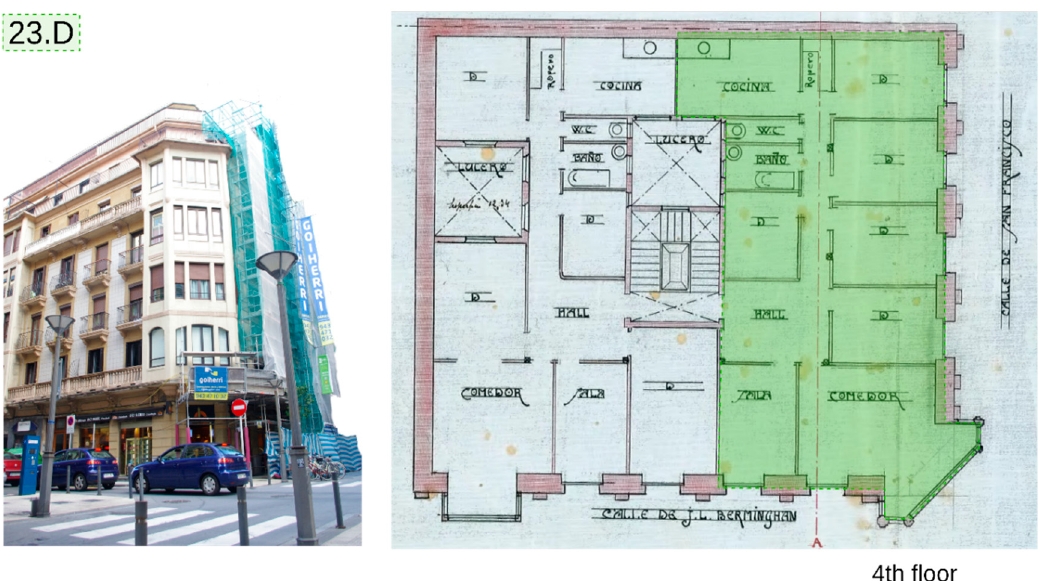
Figure A4. Floor plans of the blower door tests performed in the Bermingham 11 case study.